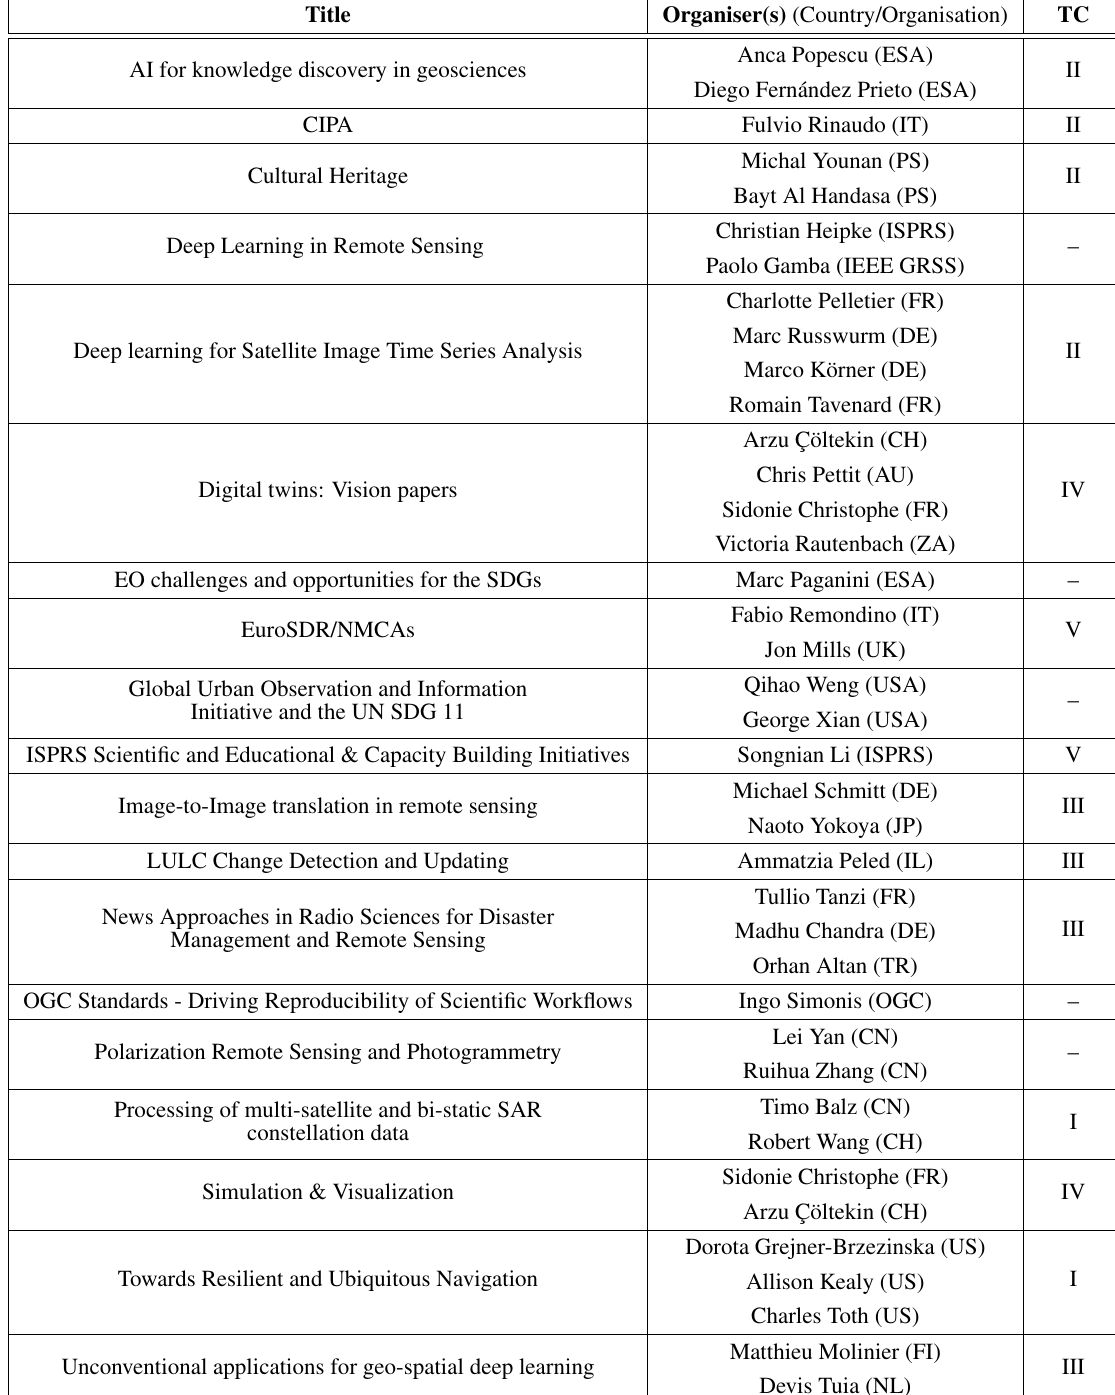
Table 1. Thematic Sessions of the 2021 edition of the ISPRS Congress. ”–” means no papers were published in the proceedings.